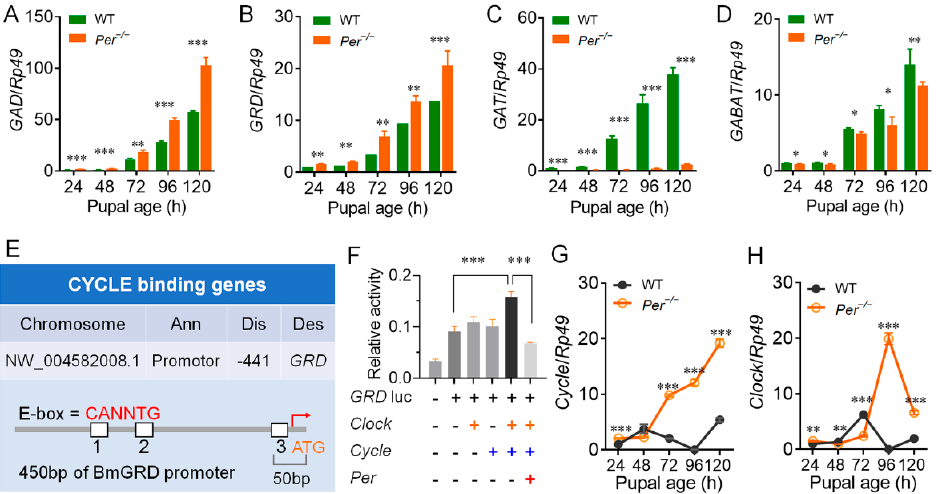
Figure 5. Per − / − affects the transcriptional regulation of key genes in the GABA pathway. ( A – D ) Gene transcription levels in the GABA pathway. GAD , glutamic acid decarboxylase; GRD , ionotropic GABA receptor; GAT , plasma membrane GABA transporter; GABAT , GABA transaminase. ( E ) ChIP-seq identification of CYCLE binding genes. Ann, Annotation; Dis, Distance to TSS; Des, Description. Genome alignment revealed that the promoter region of GRD has a binding site for CYCLE. ( F ) Dual luciferase reporter assays. GRD is activated by CLOCK and CYCLE, and inhibited by PER (sample replicates, n = 4). ( G , H ) The transcription levels of Cycle and Clock . In figures ( A – D ) and ( G , H ), eggs were incubated in 25LD. qRT-PCR was used to determine the genes transcription levels in Br-SG ( n = 3). *, p < 0.05, **, p < 0.01, ***, p < 0.001.